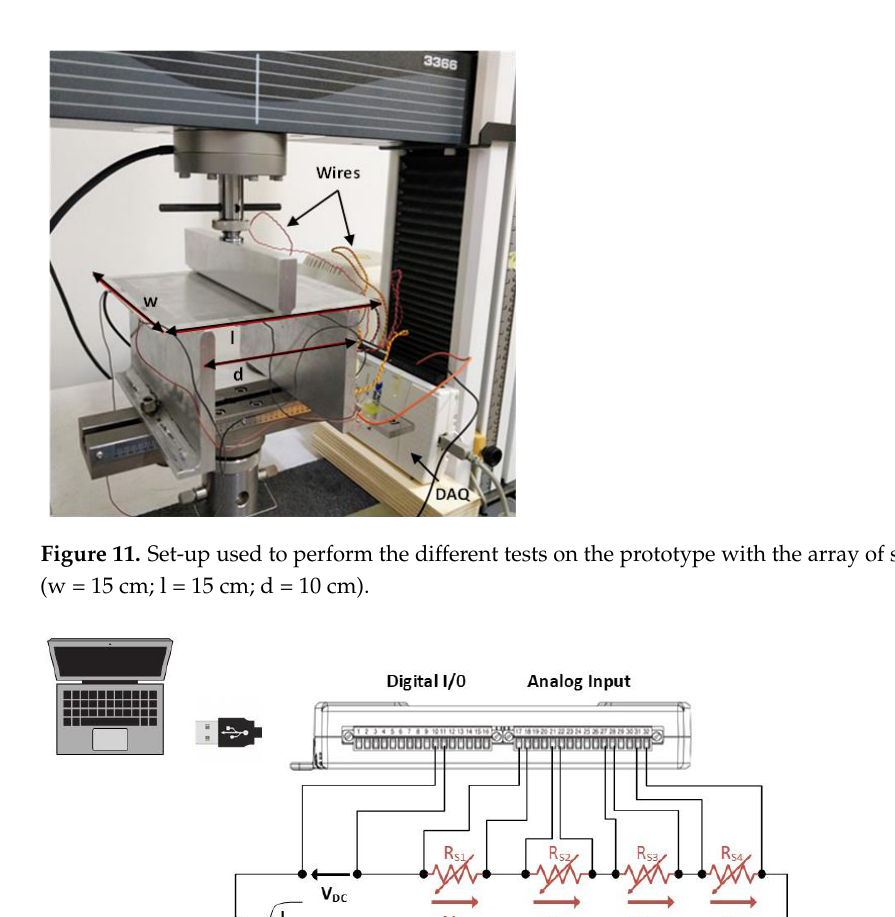
Figure 10. Trends of percentage change of resistance and variation of the gauge factor in the piezo- resistive sensor subjected to the three-point bending test, as a function of deformation.